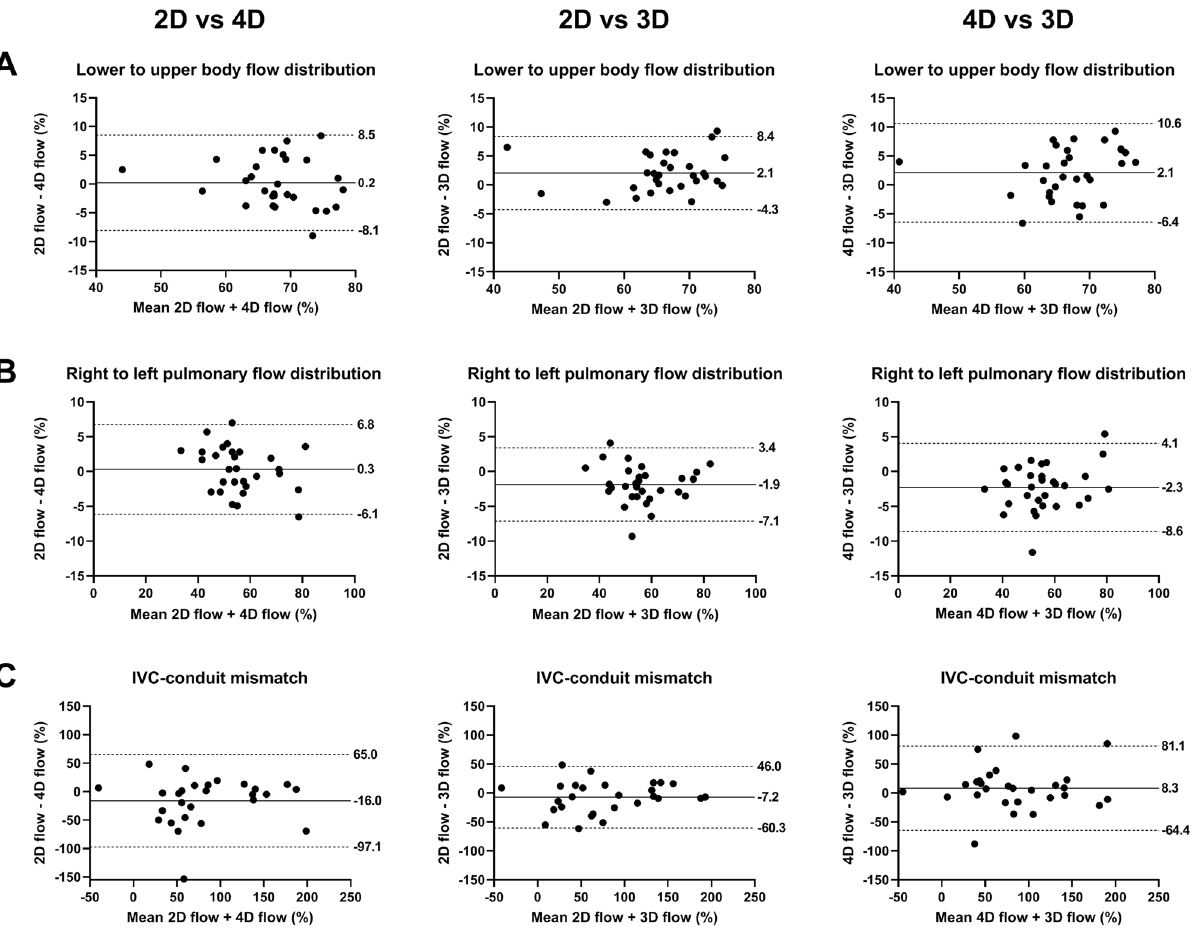
Figure 2. Bland–Altman plots comparing lower-to-upper body flow distribution ( A ), right-to-left pulmonary flow distribution ( B ) and IVC-conduit mismatch ( C ) between 2D, 3D and 4D flow. Mean bias and limits of agreement are shown. IVC; inferior vena